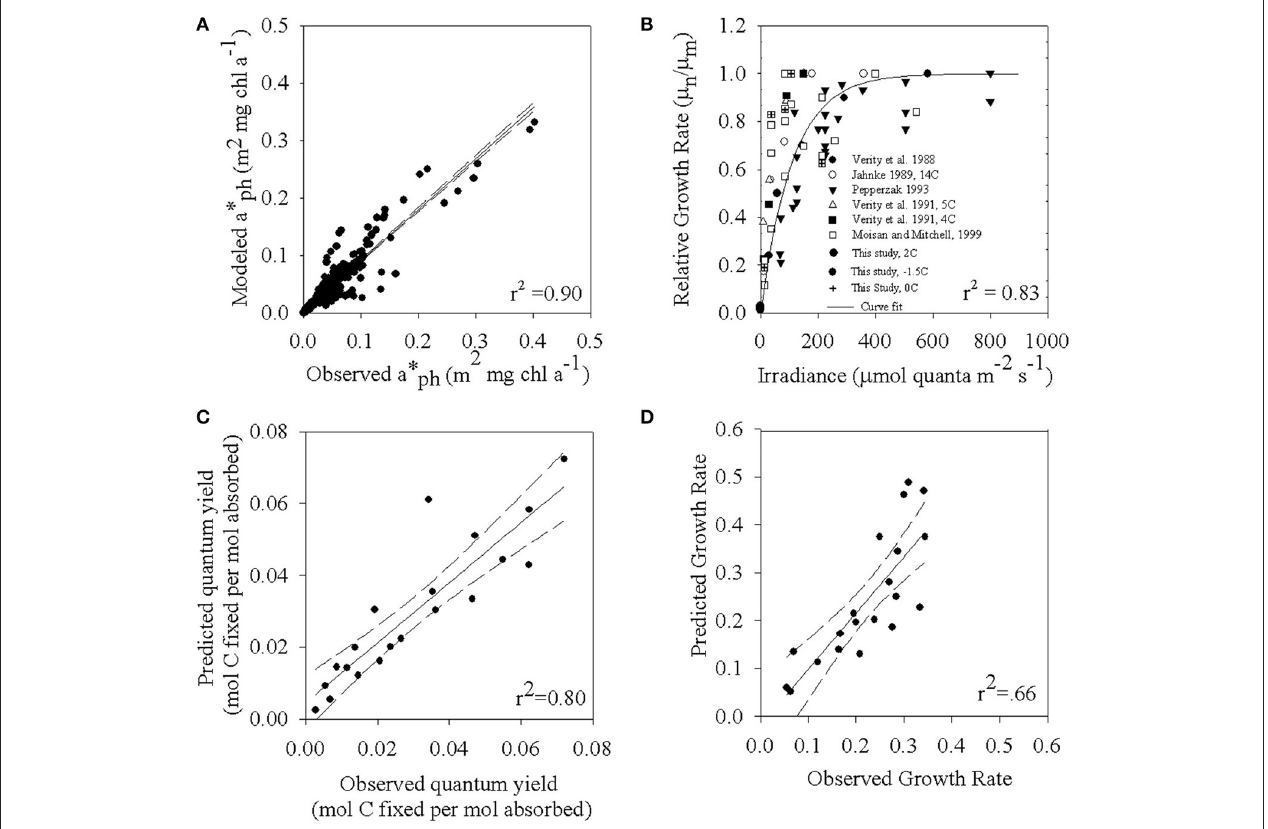
FIGURE 5 | (A) The relationship between modeled a* ph ( λ ) based on temperature and light (Equation 6, Table 4 ) and observed values at individual wavelengths. (B) Relative growth rates measured from various Phaeocystis species grown under a variety of temperature and irradiance regimes. Note that there are overlapping data points. (C) Modeled φ µ vs. observed values. There are overlapping points. (D) Relationship between the observed carbon-specific growth rate and model predictions of carbon-specific rate of net growth ( µ n ). Model is based on Equation (1) and Table 4 .